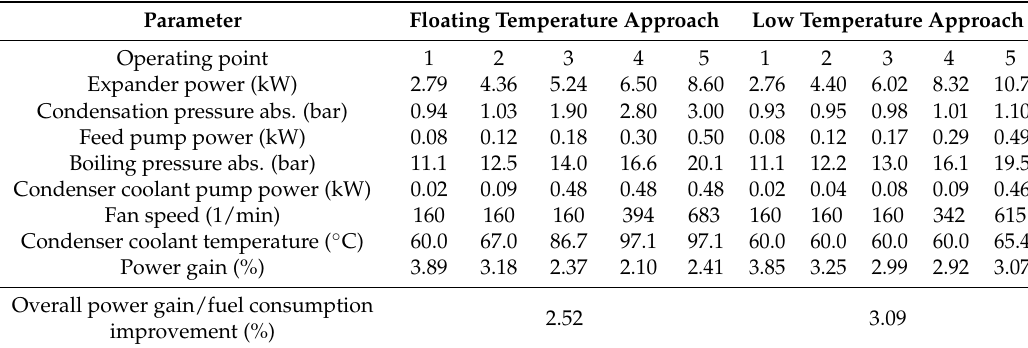
Table 2. Steady state simulation